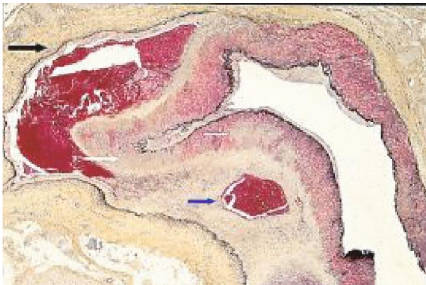
Figure 21: Segmental arterial mediolysis reparative phase. The tear space between the outer media and adventitia is widely expanded by mature granulation tissue containing a hematoma (blue arrow) and a dissecting aneurysm (black arrow). The white arrows point to foci of mature granulation tissue in the outer media a clue to SAM ’ s genesis of the dissection. Movat stain × 15 (adapted with permission from the International Journal of Surgical Pathology 15(2) copyright 2007, Sage